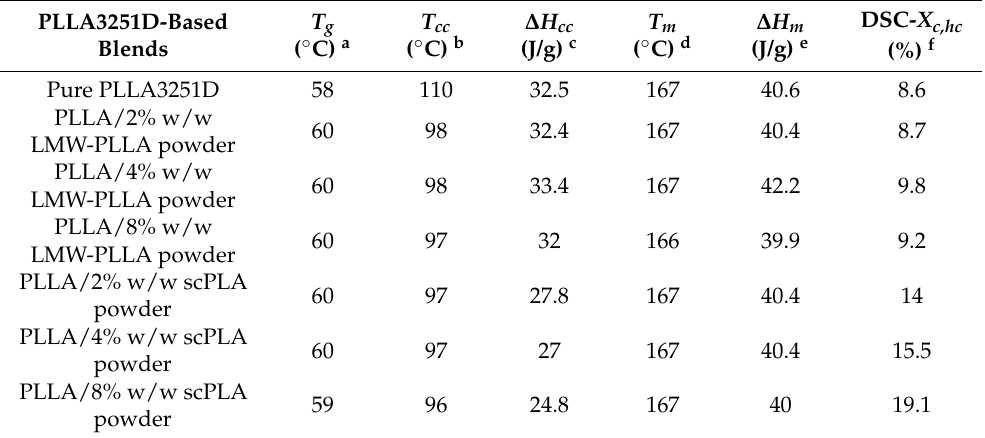
Figure 5. DSC heating curves of ( a ) pure PLLA3251D and PLLA3251D/LMW-PLLA powder blends with powder contents of ( b ) 2%, ( c ) 4%, and ( d ) 8% w / w as well as PLLA3251D/scPLA powder blends with powder contents of ( e ) 2%, ( f ) 4%, and ( g ) 8% w / w ( T g , T cc and T m peaks as shown). Table 3. Thermal transition properties of PLLA3251D-based blends obtained from DSC heating curves in Figure 5.